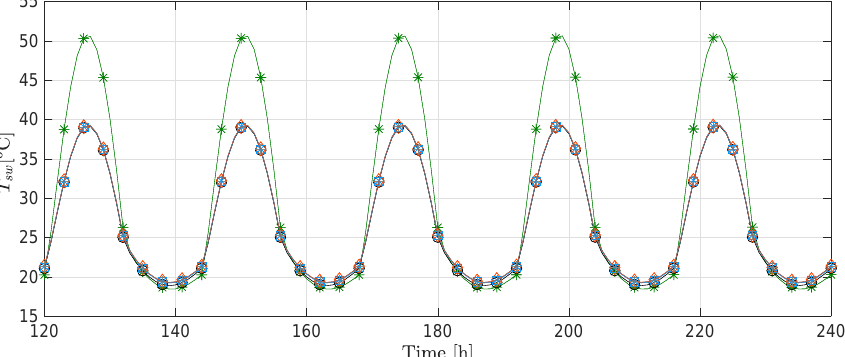
Figure 19. ICB-substrate system facade surface temperature T sw distribution over time: ( ∗ ) without canopy, ( ◦ ) e = 0.00 m; ( (cid:3) ) e = 0.05 m; (+) e = 0.10 m; ( × ) e = 0.15 m; ( (cid:5) ) e = 0.20 m. Figure 20 illustrates the time dependence of the driving potentials (t = 216, 222, 228 and 234 h), such as the relative humidity ϕ ( t , x ) , water content W ( t , x ) , and temperature T ( t , x ) throughout the multilayer wall cross section with and without substrate. Without Substrate With Substrate